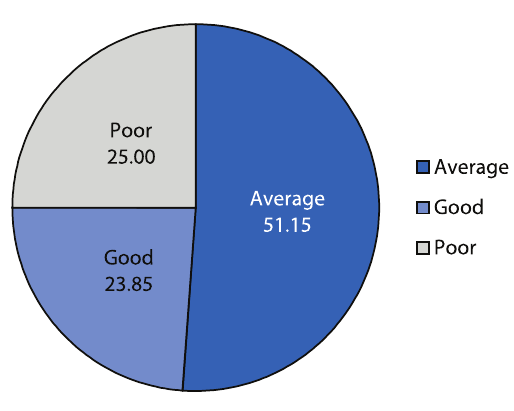
Figure 1: Participants’ knowledge of ZVD.